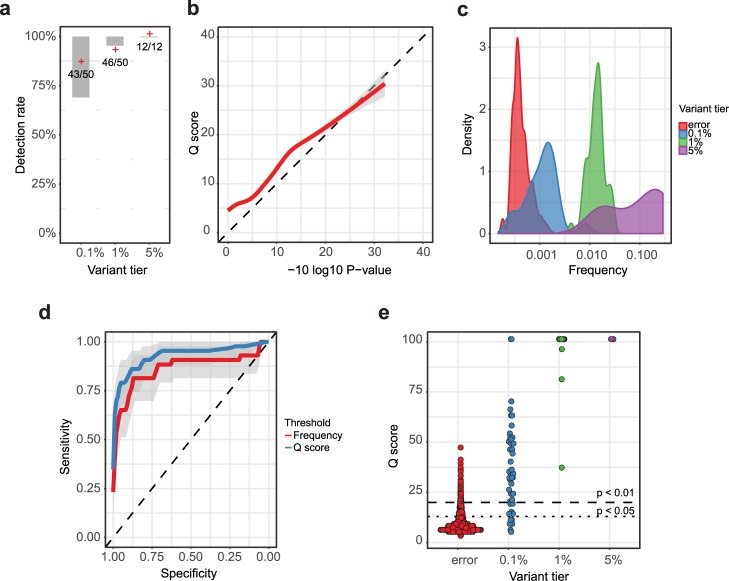
MAGERI software benchmark using Tru-Q 7 reference standard and control donor DNA.a Number of detected variant for each variant frequency tier across two independent experiments with the reference standard. Shaded areas show the 95% confidence intervals for expected fraction of recovered variants, i.e. binomial proportion confidence intervals built using known variant frequency and template coverage. b Frequency distribution of known Tru-Q 7 variants coming from each frequency tier and errors in the control donor DNA. c MAGERI Q score and the empirical P-values of erroneous variants detected in control donor DNA. d Comparison of Q score distribution of erroneous variants and variants of each frequency tier. Dotted and dashed lines show P < 0.05 and P < 0.01 thresholds respectively. e Receiver operation characteristic (ROC) curve comparing the sensitivity and specificity of MAGERI Q scores (blue line) and frequency-based thresholding (red line) in the task of classification of errors and 0.1% tier variants.